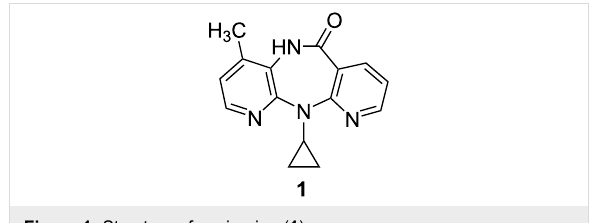
Figure 1: Structure of nevirapine ( 1